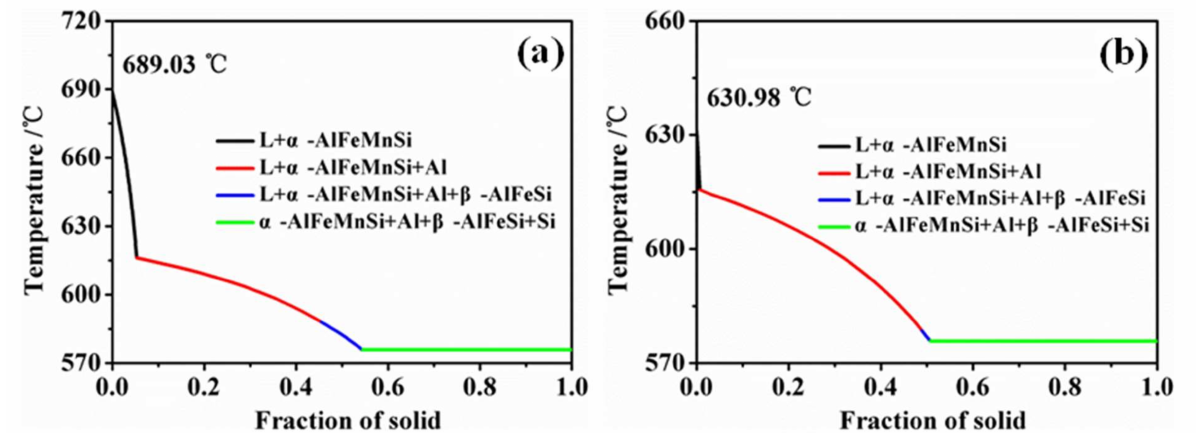
Figure 8. Equilibrium solidification curve of Fe18 alloy calculated by PANDAT TM . ( a ) Before melt treatment; ( b ) After melt